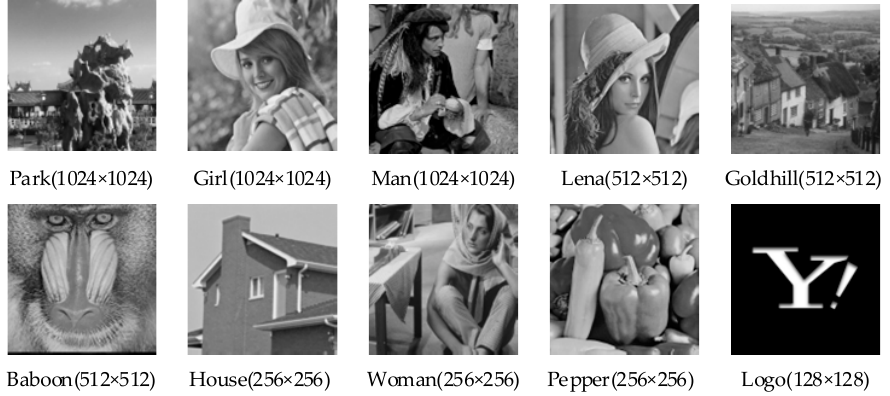
Figure 7. The host image and watermark image.